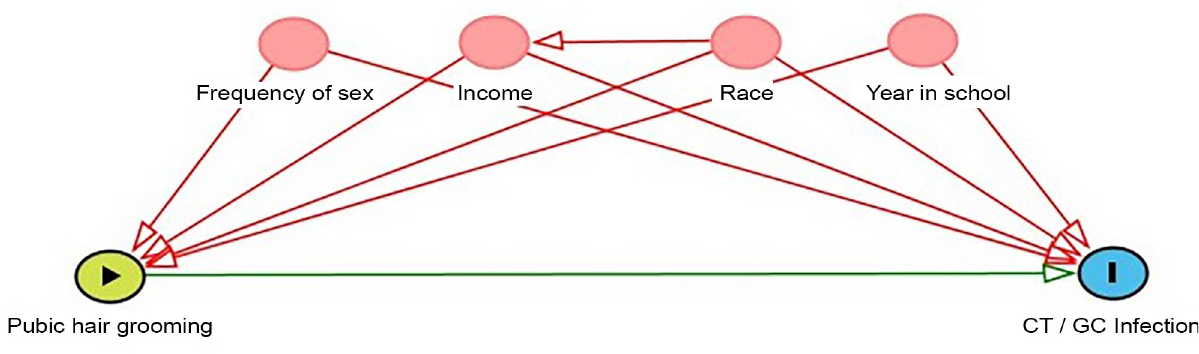
Fig 1. Directed acyclic graph. The minimally sufficient adjustment set includes the variables frequency of sex, income, race, and year in school.